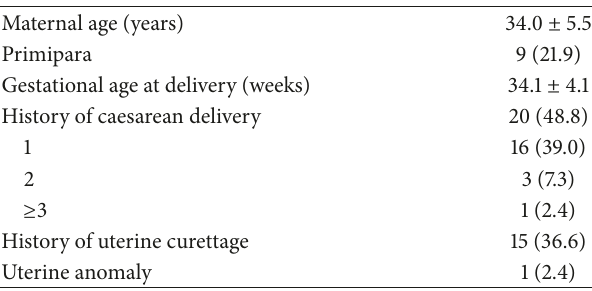
Table 1: Demographic data of the study group. Results are expressed as number, mean ± SD, or incidence